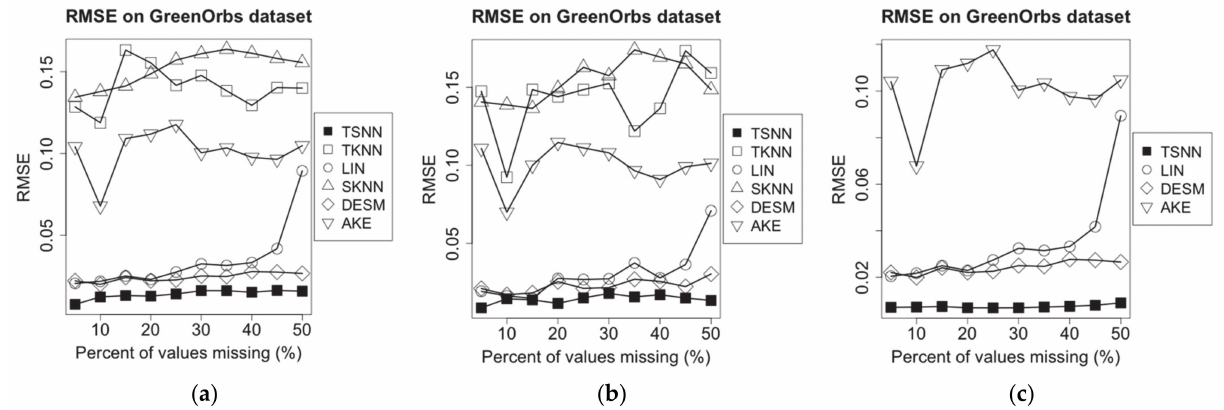
Figure 10. RMSE of imputation algorithms on temperature data of GreenOrbs dataset for the three scenarios: ( a ) temperature NA and humidity not NA, ( b ) temperature NA and humidity 50% NA and ( c ) temperature NA and humidity NA.